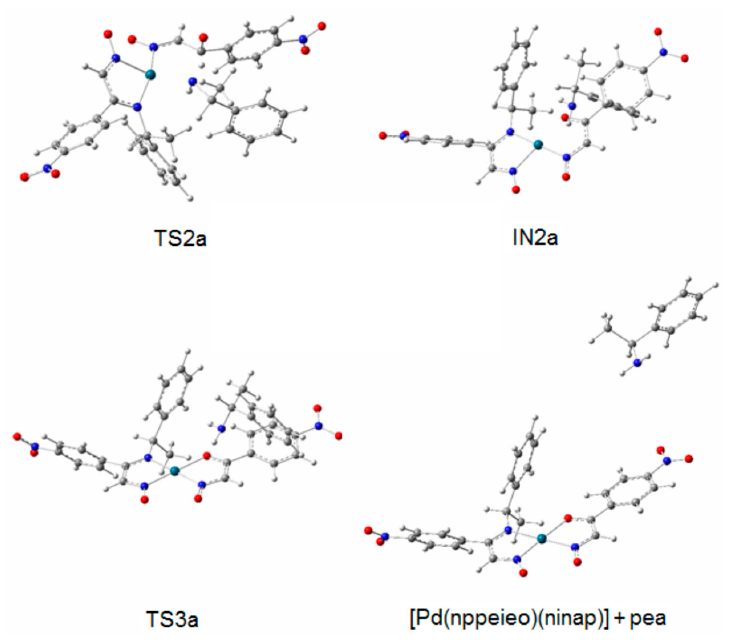
Figure 4. Optimized structures of TS2a, IN2a, TS3a and [Pd(nppeieo)(ninap)] + pea.